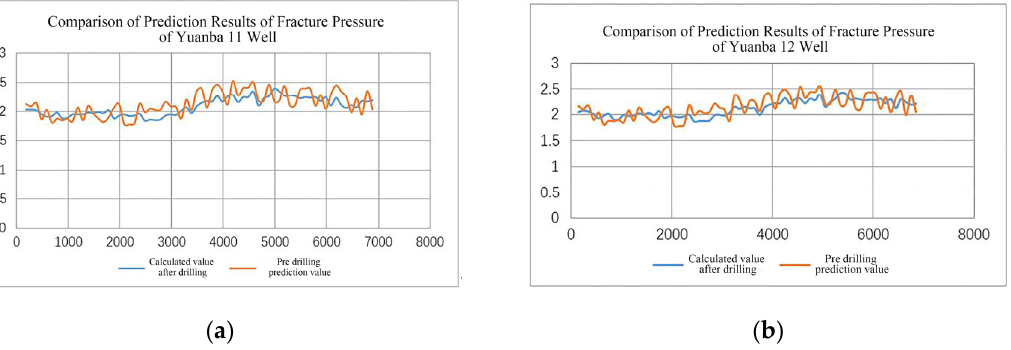
Figure 6. Comparison of fracture pressure prediction. ( a ) Comparison of Prediction Results of Fracture Pressure of Yuanba 11 Well ( b ) Comparison of Prediction Results of Fracture Pressure of Yuanba 12 Well. Table 1. Comparison table of formation fracture pressure prediction results and actual drilling data of Yuanba 11 well.